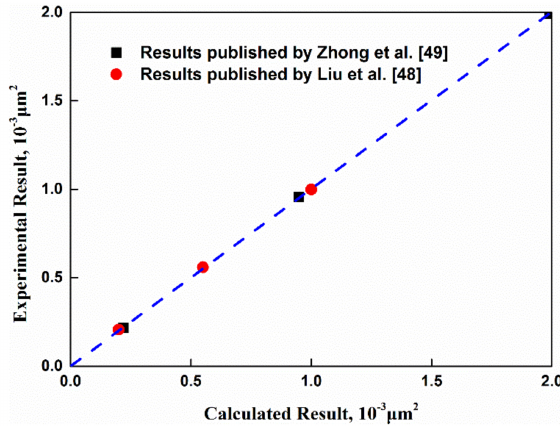
Figure 2. The comparison between initial permeability calculated by the proposed model and that found in experiments.